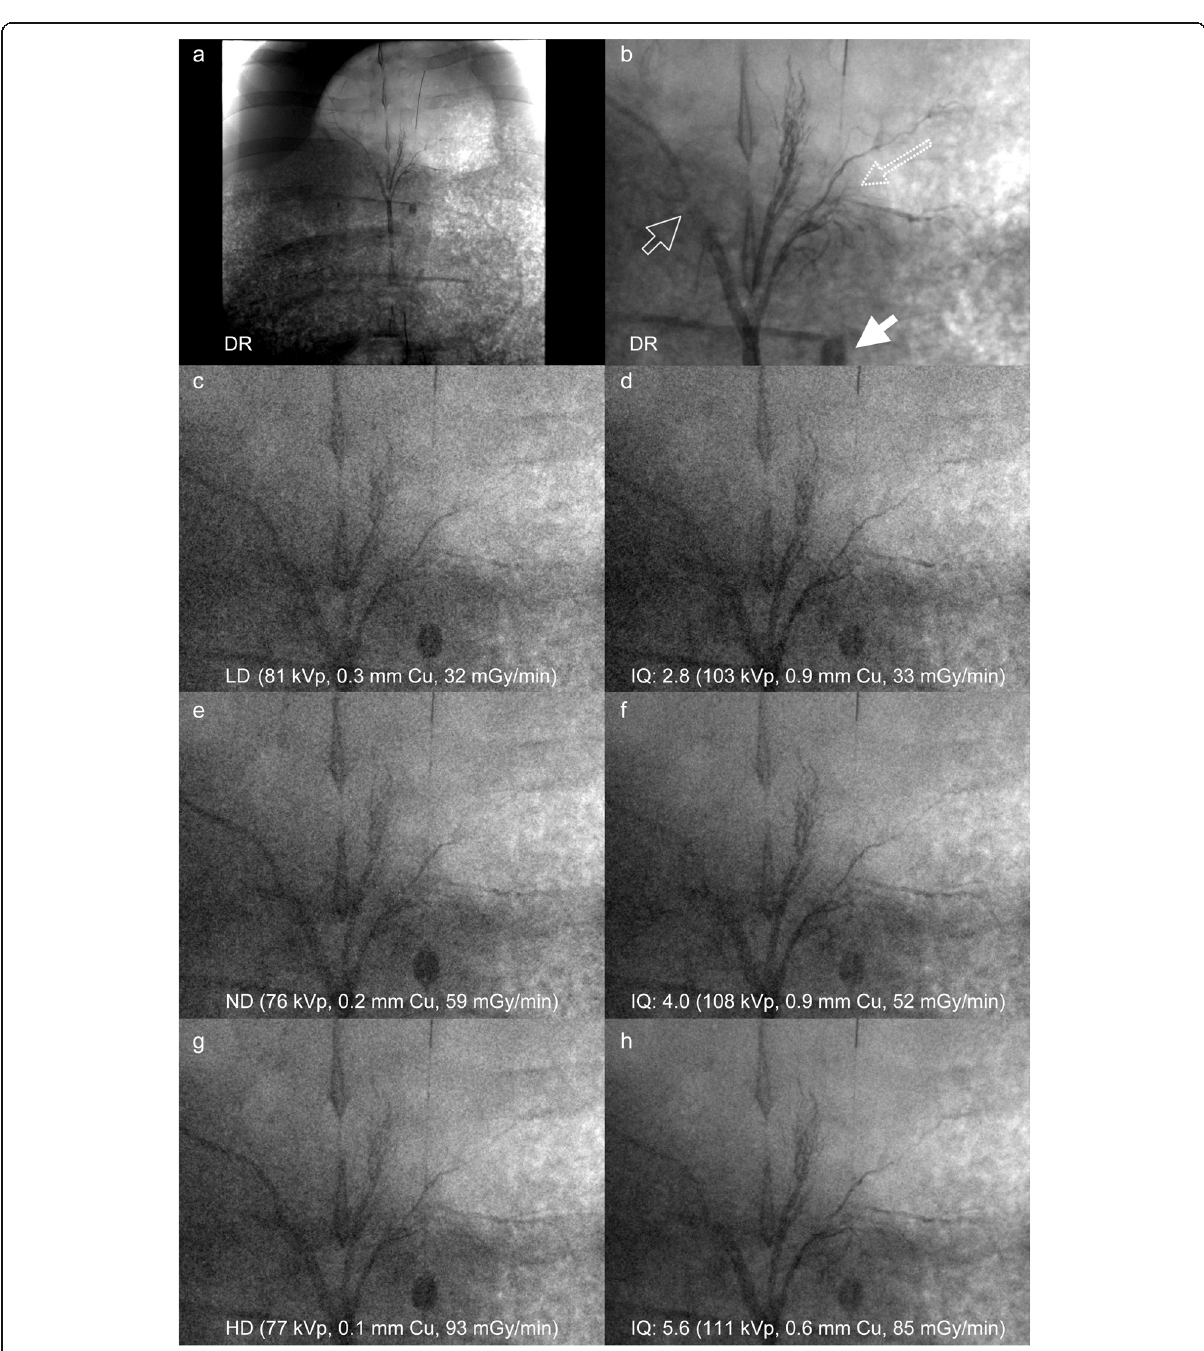
Fig. 1 Example of fluoroscopic images of the liver at 32 cm water value acquired with the detector dose-driven exposure control using the three detector dose levels (LD low dose, ND normal dose, HD high dose) in comparison with fluoroscopic images acquired with the Ta-specific contrast-to-noise ratio-driven exposure control at a comparable incident air kerma rate (dose equivalent Ta image). The first row shows the overview image ( a ) and the magnified reference image ( b ), which were acquired with digital radiography (DR). The iodine mixed with cyanoacrylate-filled vessels and the iodine-filled balloon are indicated by the open and closed arrow. The dotted arrow indicates the tantalum filled gastric and liver arteries. IQ Image quality